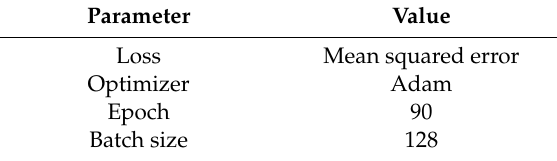
Table 2. CNN training parameters.